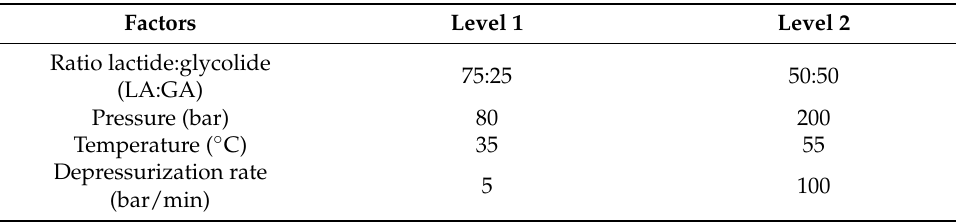
Table 1. Different factors and levels considered for the impregnation experiments Factors Level 1 Level 2 Ratio lactide:glycolide 75:25 50:50 (LA:GA) Pressure (bar) 80 200 Temperature ( ◦ C) 35 55 Depressurization rate 5 (bar/min)